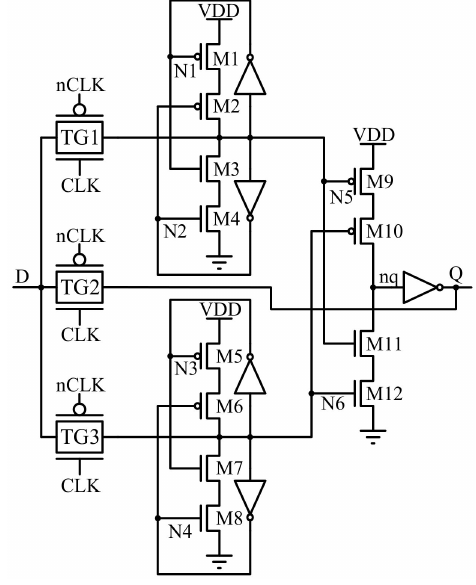
Figure 2. Schematic of LCHRNAN latch.